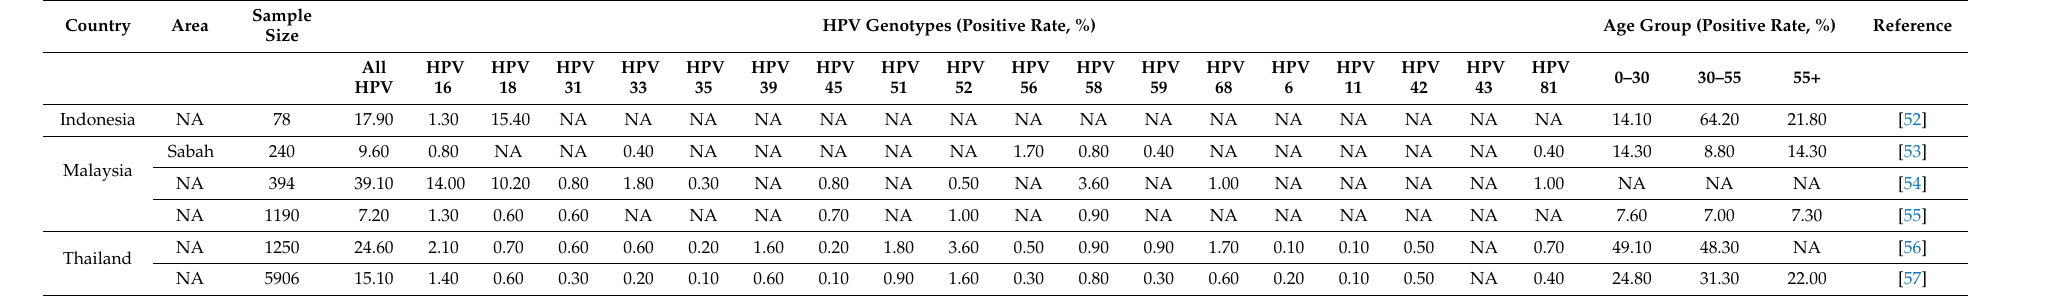
Table 4. The positive detection rate of HPV prevalence in cervical lesions by countries and age groups in Southeast Asia.